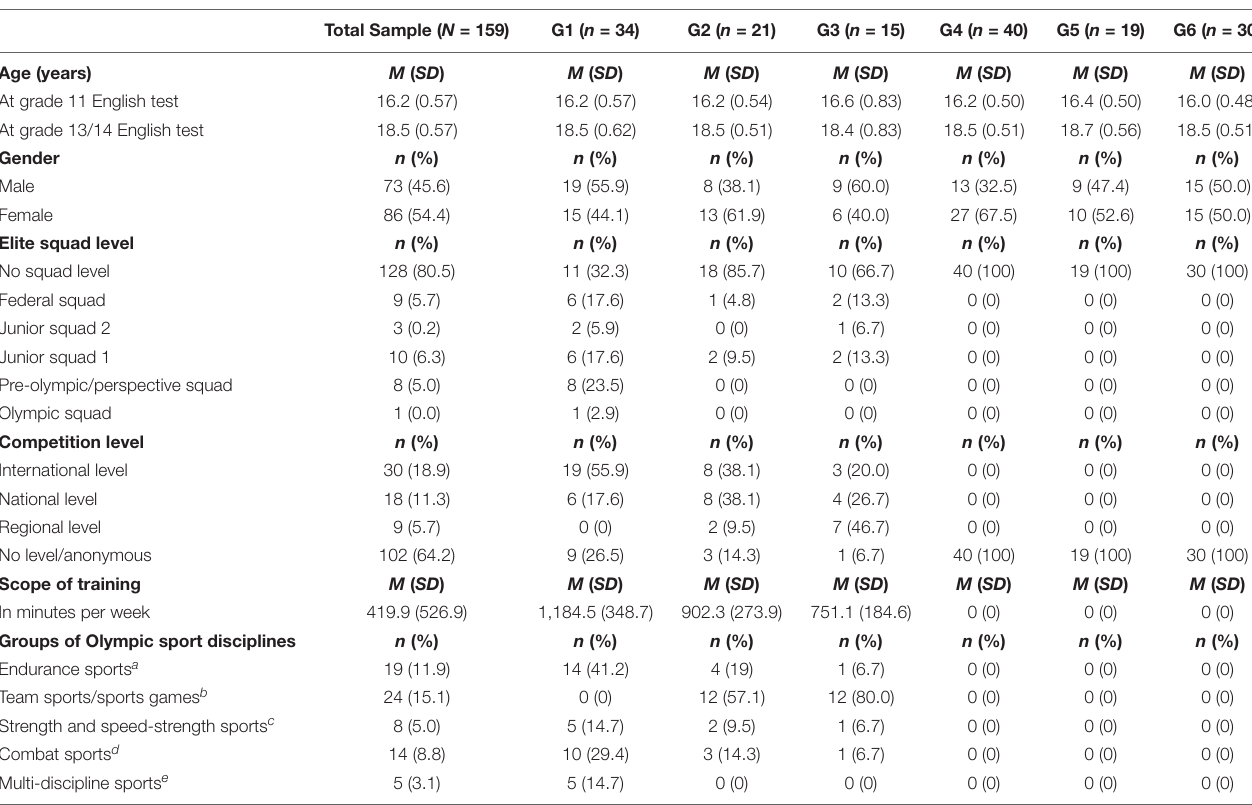
TABLE 3 | Description of samples with students in grade